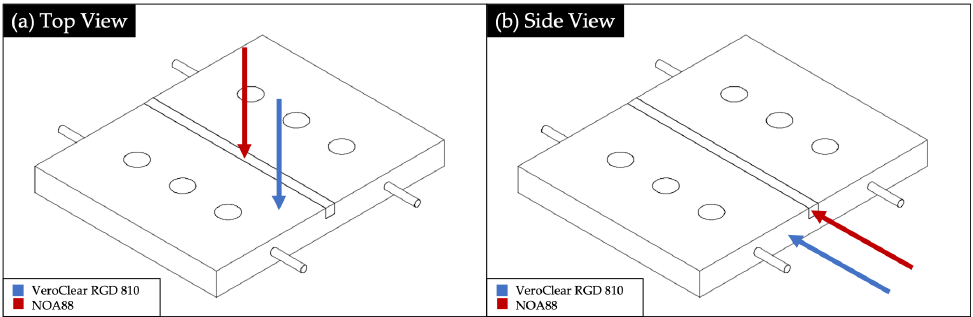
Figure 11. Surfaces of the surface plasmon resonance (SPR) device analyzed by atomic force mi- croscopy (AFM): ( a ) top view; ( b ) side